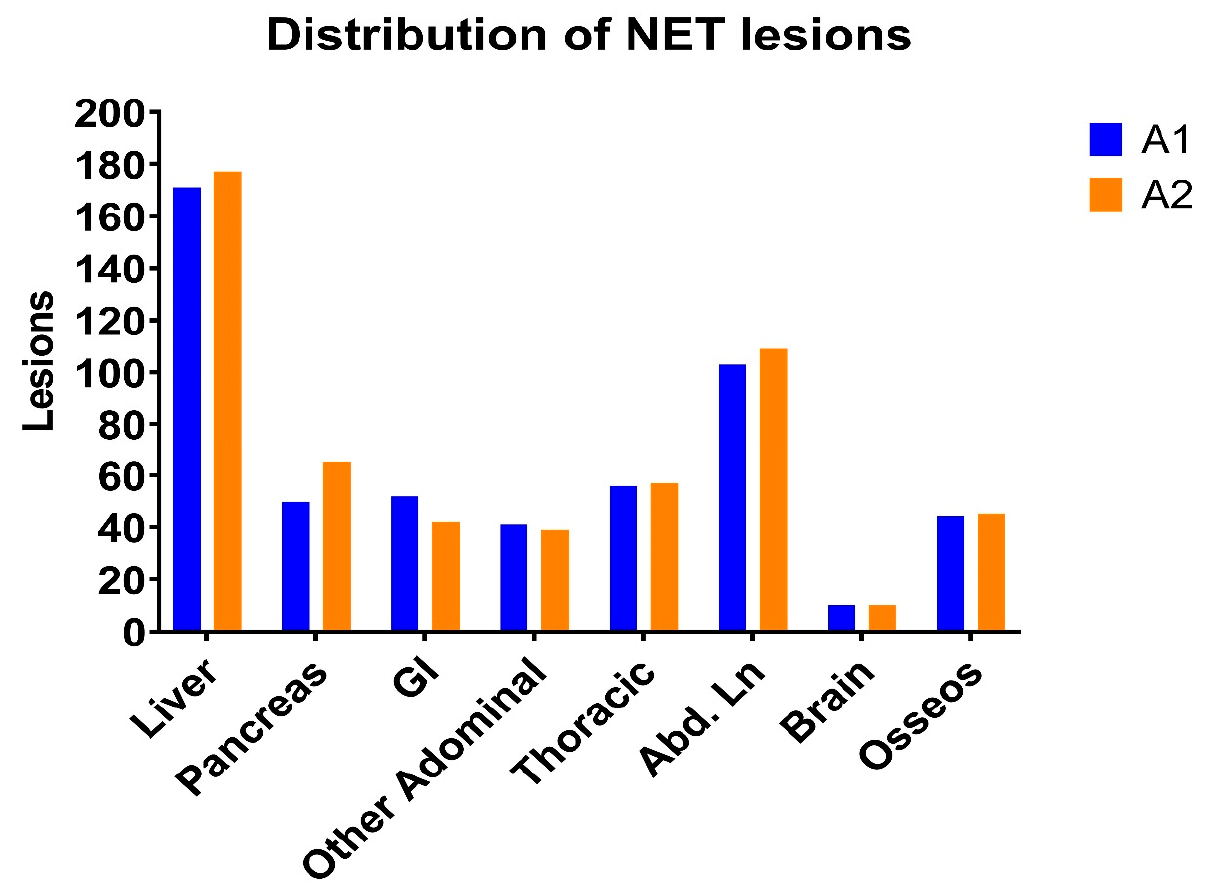
Figure 1. 68 Ga-DOTATOC-PET/CT-positive lesions in NET patients. Abbreviations: Abd. Ln: abdominal lymph node; GI: gastrointestinal. Table 1. 68 Ga-DOTATOC-PET/CT-positive lesions in NET patients.